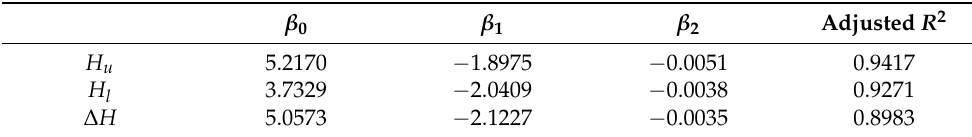
Table 3. Fitted coefficient values in Equations (1)–(3)